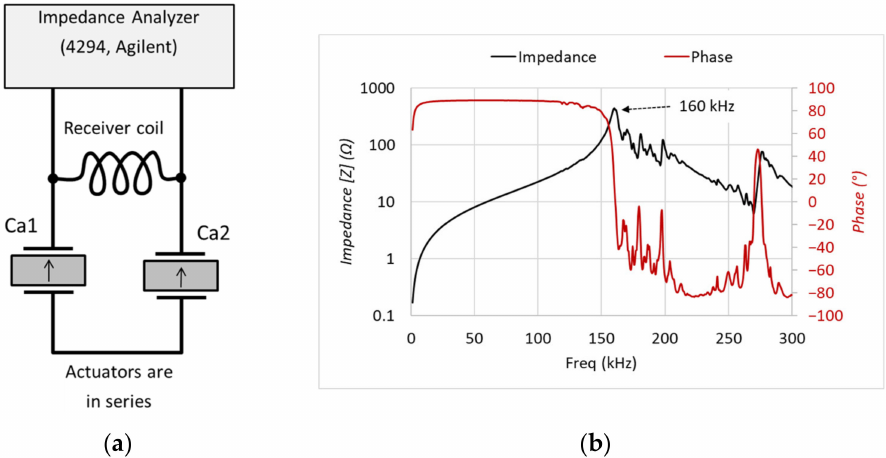
Figure 8. ( a ) Connection of the receiver side to the impedance analyzer. ( b ) Impedance magni- tude and phase spectra of the receiver coil connected in parallel to serially connected piezoelectric multilayer